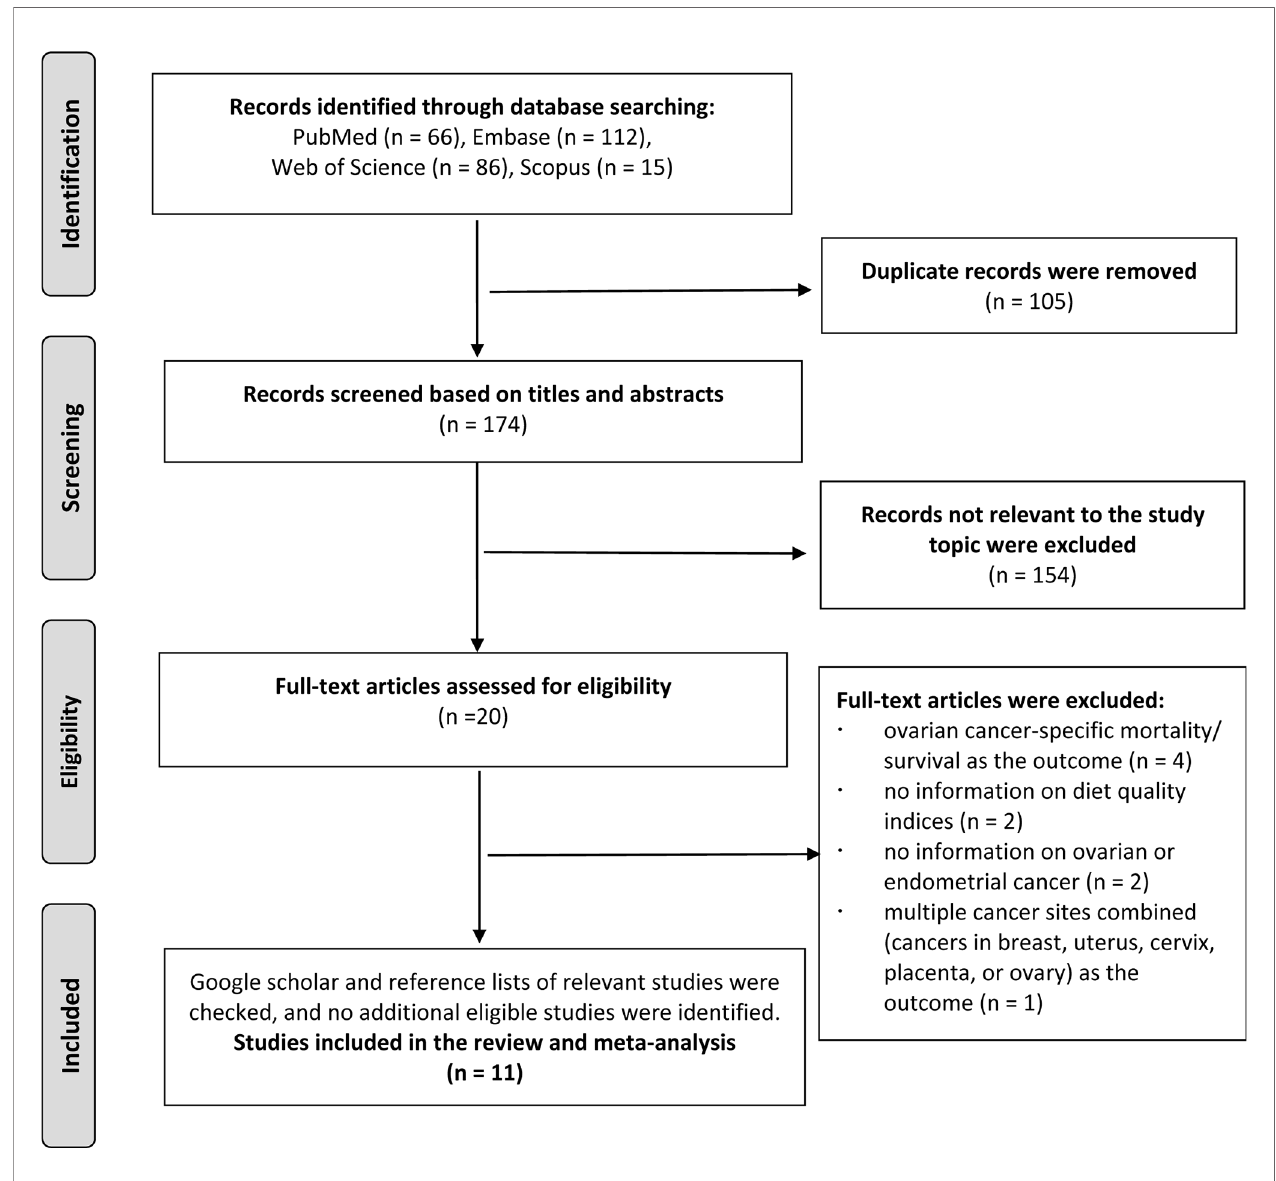
FIGURE 1 | Flow diagram of study